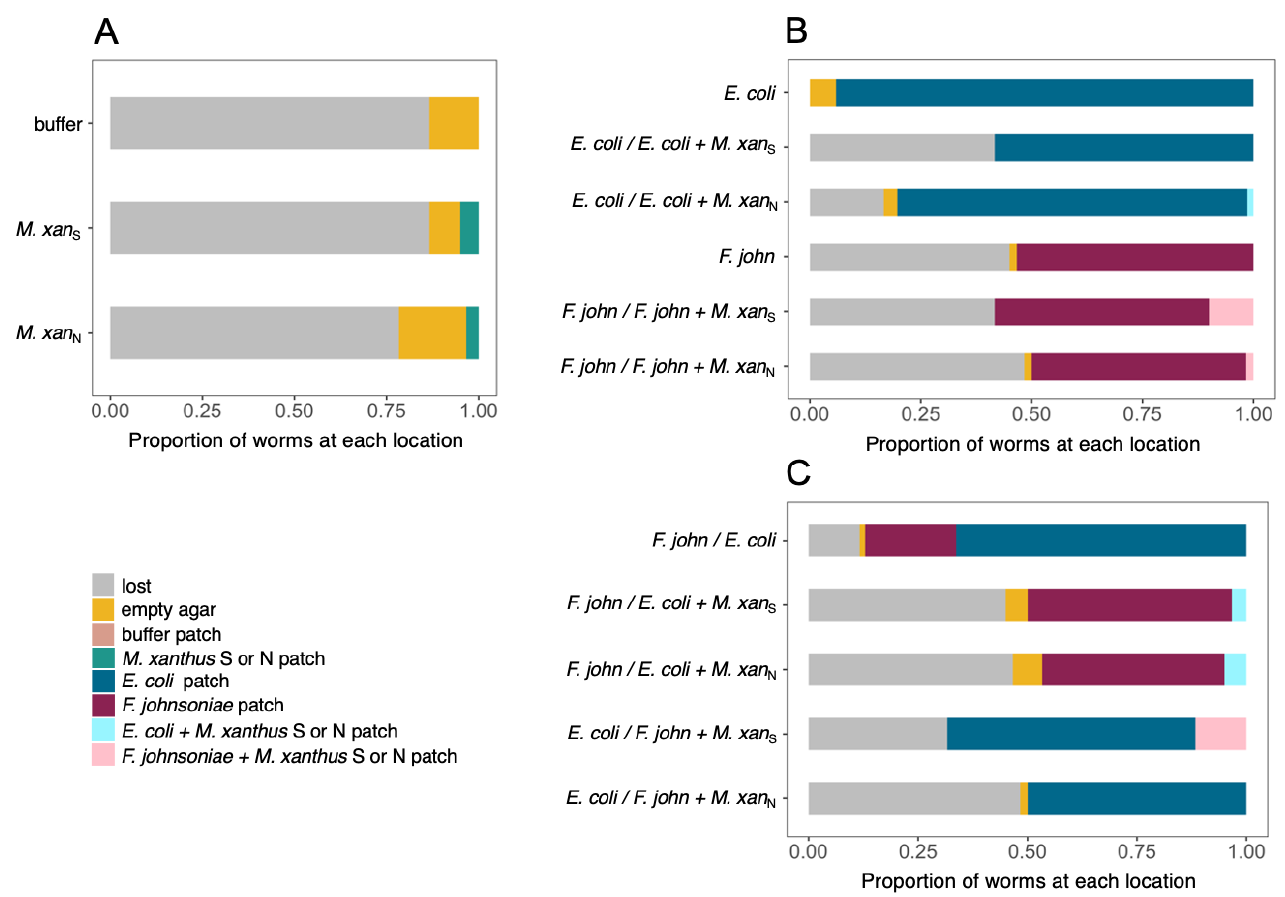
Figure 3. C. elegans prefers prey patches not containing M. xanthus . Here we show worm locations relative to two circular prey patches after 25 h on plates where either ( A ) the patches contained either buffer or M. xanthus , ( B ) one patch contained E. coli or F. johnsoniae and the other patch contained the same with or without pre-mixed M. xanthus , or ( C ) one patch contained E. coli or F. johnsoniae and the other patch contained the other prey species with or without pre-mixed M. xanthus . Worms found on the plate but not in a patch are indicated in yellow, and worms that had left the plate by 25 h are indicated in grey. Bars are mean worm counts from three biological replicates. Raw data are shown in Figure S2. ‘ F. john ’ = F. johnsoniae , ‘M.xan N ’, ‘ M.xan S ’ = M. xanthus strains N and S, respectively.